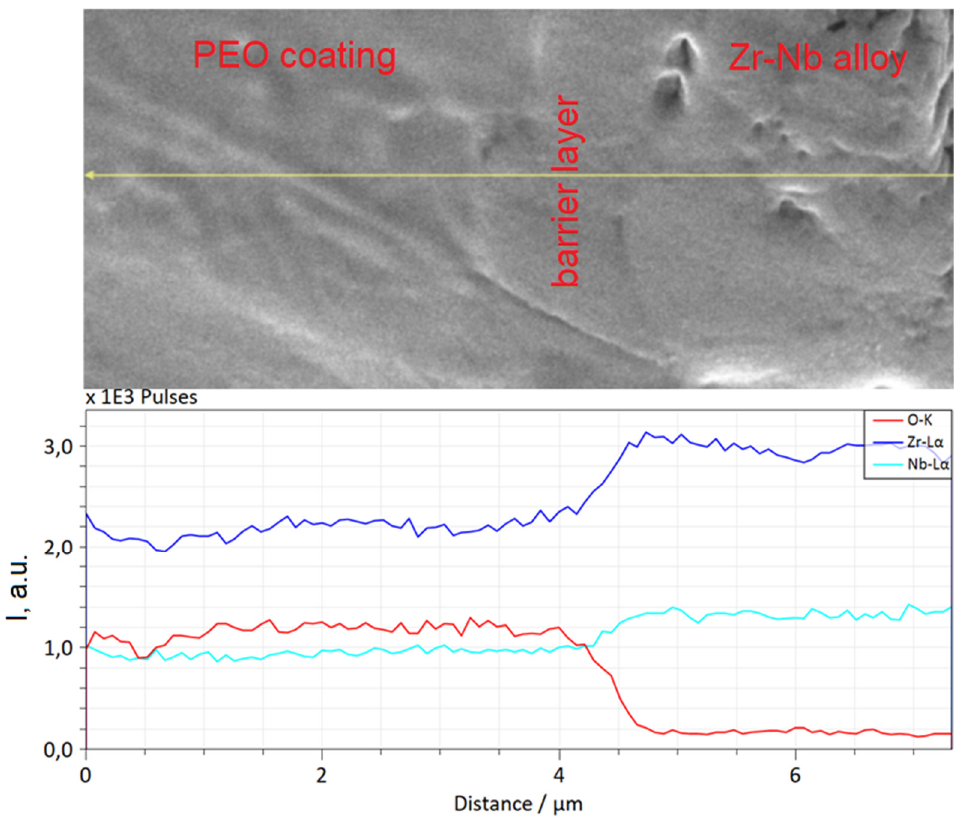
Figure 5. The cross-sectional microstructure of the barrier layer and elements distribution along the marked line.